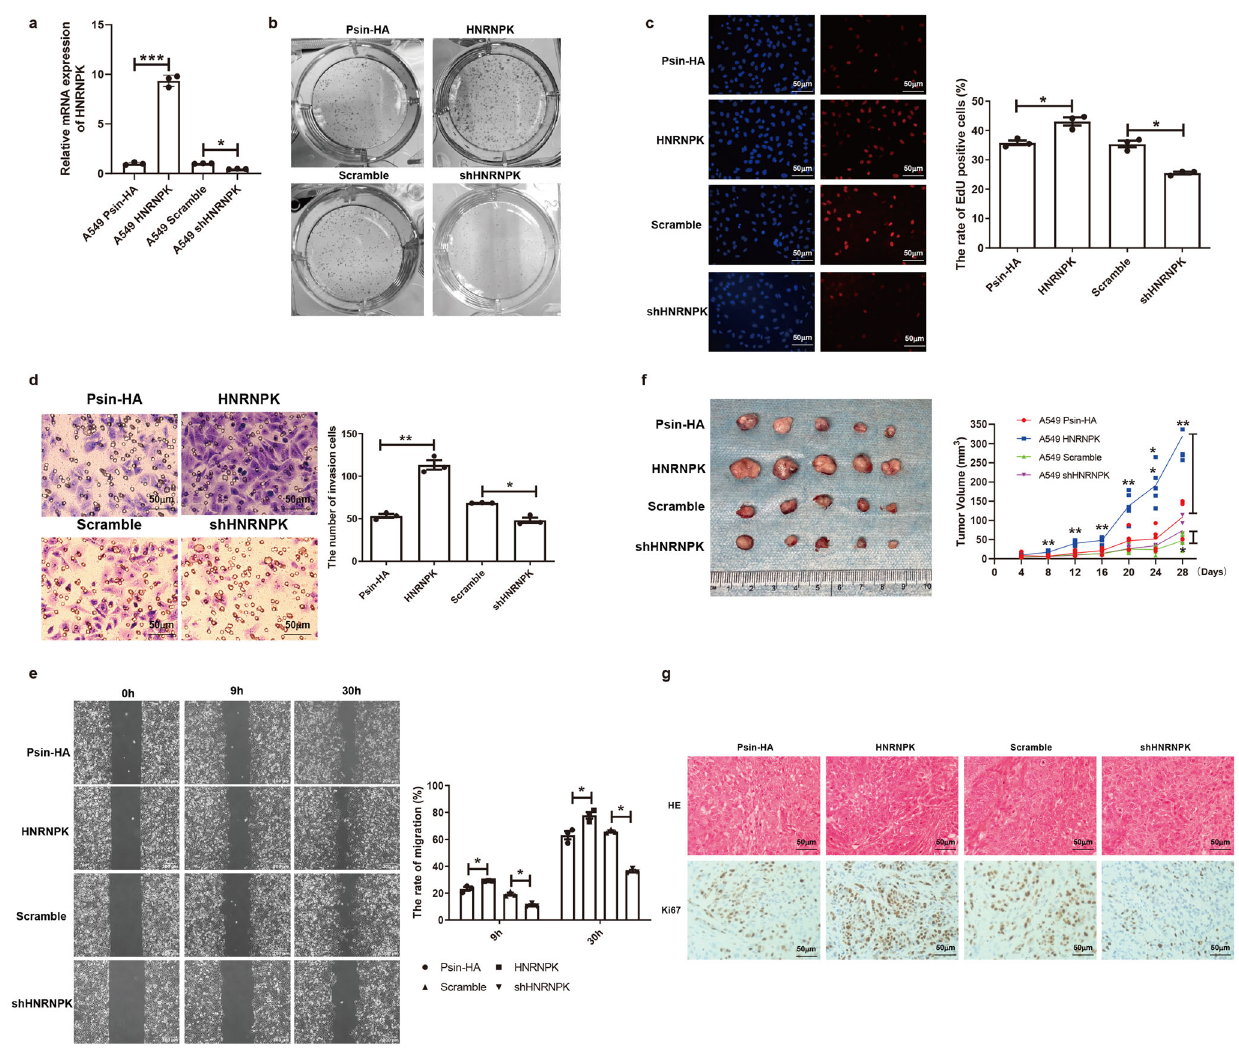
Fig. 4 HNRNPK promote cancer cell growth, invasion and migration. a Relative mRNA expressions of HNRNPK in overexpression and knockdown conditions. Error bars showing the variances. b Colony formation assays of the effects of overexpression/knockdown of HNRNPK vs. controls. c The rate of EdU positive cells for overexpression/knockdown of HNRNPK vs. controls. Error bars showing the variances. d The number of invasion cells for overexpression/knockdown of HNRNPK vs. controls. Error bars showing the variances. e The rate of migration of cancer cells for overexpression/ knockdown of HNRNPK vs. controls. Error bars showing the variances. f Tumor volumes for overexpression/knockdown of HNRNPK vs. controls. g IHC for Ki67 in overexpression/knockdown of HNRNPK vs.